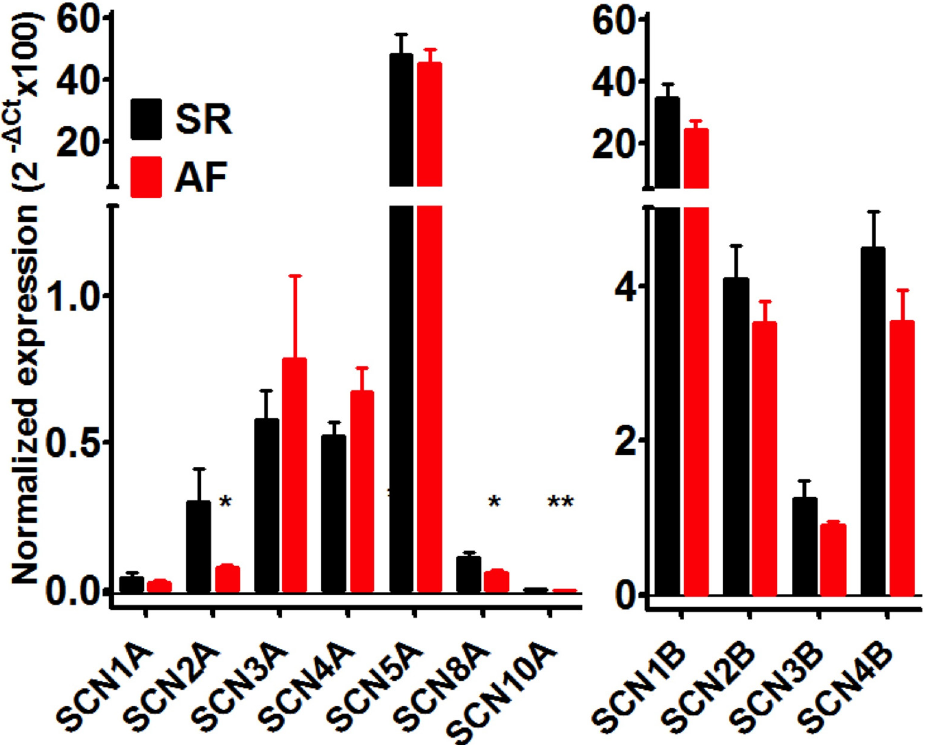
Fig 6. Expression of sodium channel subunits in right atrial tissue from patients in SR and AF. mRNA expression of various Na + channel alpha- (left) and beta- (right) subunits was quantified by qPCR in 10 and 14 samples of patients in SR and AF respectively. * p < 0.05; unpaired Student ‘ s t